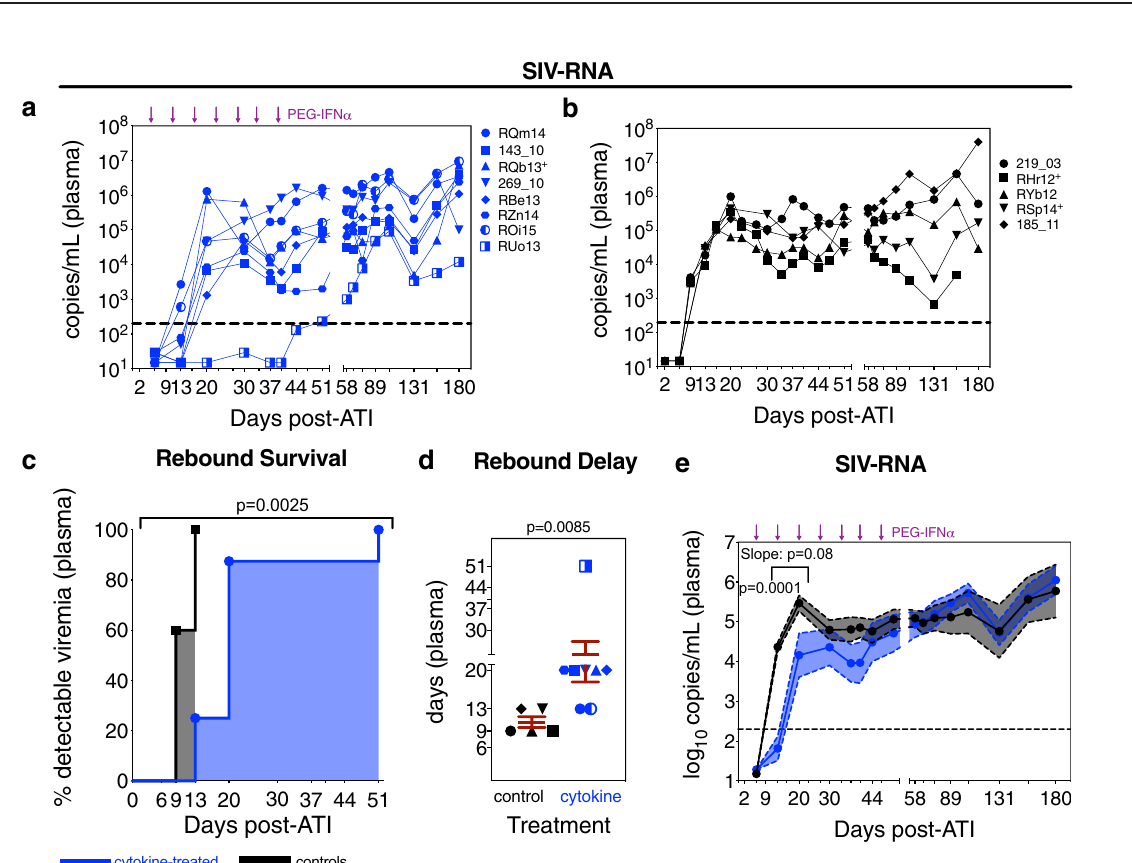
Fig. 3 Cytokine therapy promotes the maturation of NKG2a/c low CD16 + NK cells with enhanced ex vivo innate activity, which correlates with the content of lymphoid replication competent virus. a The frequency of NK cells (CD45 + CD20 − CD3 − NKG2a/c + ) of PBMC CD45 + lymphocytes was longitudinally measured by fl ow cytometry, b as was their CXCR5 expression. The frequency of each differentiation stage of NK cells was determined based on the following de fi nition: c Stage 0 (red, NKG2a/c low CD16 − ), d Stage 1 (blue, NKG2a/c high CD16 − ), e Stage 2 (orange, NKG2a/c high CD16 + ), and f Stage 3 (purple, NKG2a/c low CD16 + ). g The mean frequency of each NK cell differentiation stage from above was also re-visualized as a color-coded (as annotated below), parts-of-whole stacked bar plot for the cytokine-treated ( n = 8; at left) and control RMs ( n = 5; at right) over time (indicated at left). Flow cytometry was used to quantify the ex vivo innate frequency of h IFN- γ + (intracellular) NK cells and i CD107a + (surface) stage 3 (NKG2a/c low CD16 + ) NK cells. a – i Data from individual RMs (staggered open circles) are overlaid against the mean (solid line) ± SEM (shaded region within the dashed lines): control (ART-only, black; n = 5) and cytokine-treated (ART + IL-21 + IFN α , blue; n = 8). Treatment phases are indicated with the following background shading: IL-21 (orange), rIFN α (red), and ART (gray). Data were analyzed with two-sided (95% CI), two-way ANOVA with Bonferroni ’ s correction with cross-sectional comparisons relative to controls. j The frequencies of each differentiation stage of NK cells in PBMCs (as indicated below) were correlated against levels of cell-associated and replication competent SIV content in tissue, and the ex vivo innate and Env-speci fi c NK cell activities in PBMCs (as indicated at left) in all RMs ( n = 13; days 35, 77, 217, and 374 p.i. as matched data are available). Per each correlation the two-tailed (95% CI) Spearman ’ s rank correlation coef fi cient (rho) is represented as a double-gradient heatmap and the size of each data point corresponds inversely to the log 10 -transformed Spearman ’ s p value. The false discovery rates (FDR) were calculated using SAS and signi fi cant values ( Q <0.05) are represented by a black border.